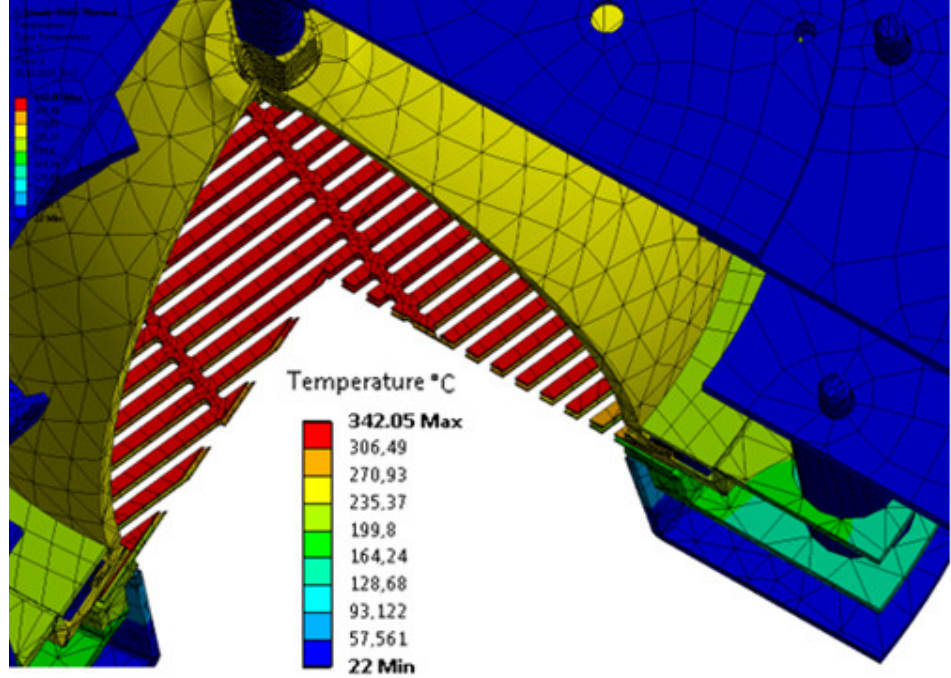
Figure 4. Predicted temperature patterns in the IS from the GDC end (sectional view).